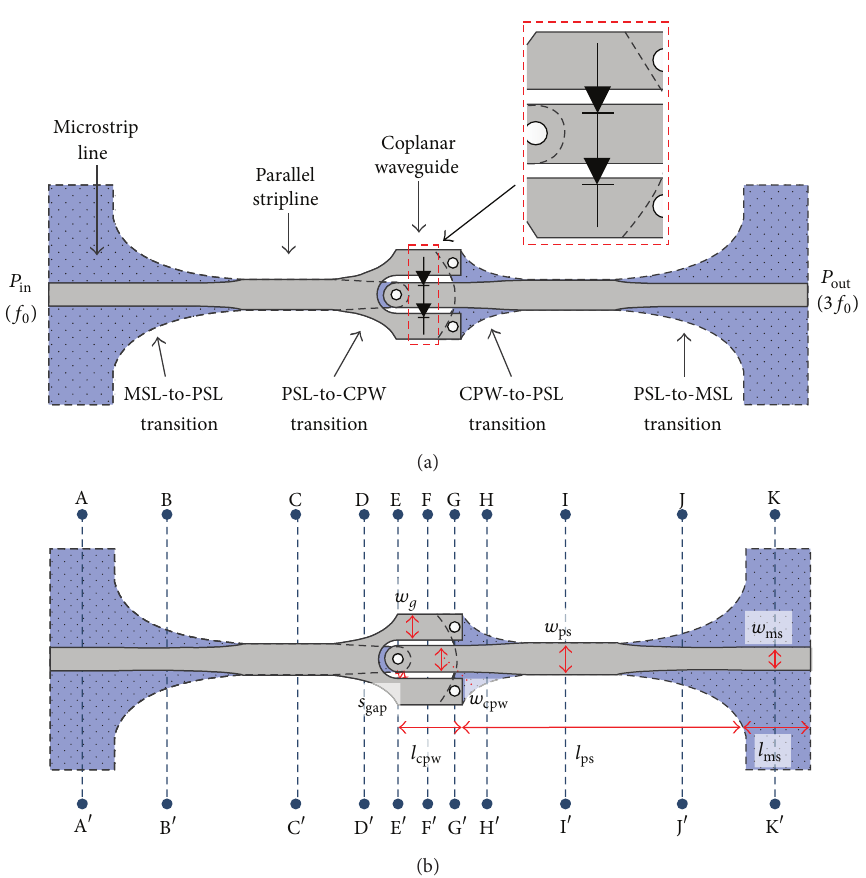
Figure 2: Proposed frequency tripler (Type A): (a) structure; (b) transition.